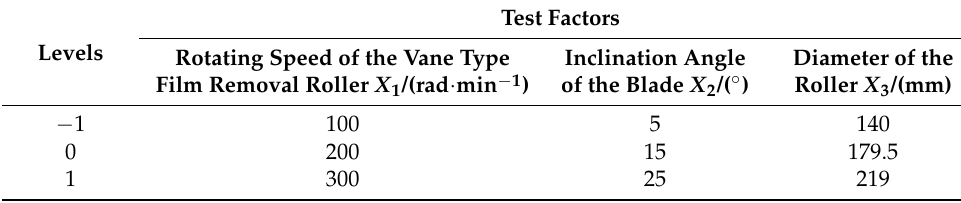
Table 3. Test factors and